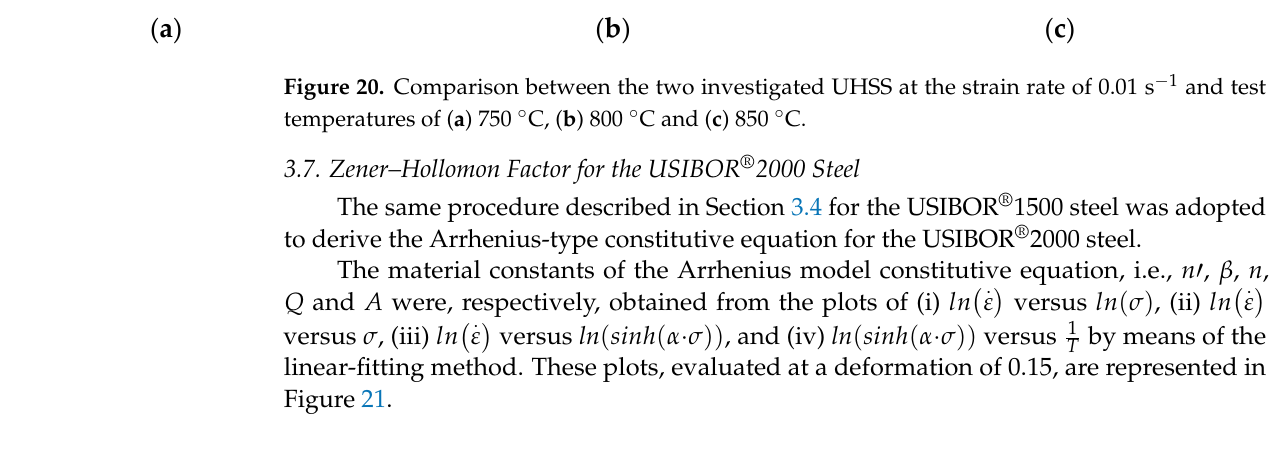
( d ) Figure 21. Relationship between ( a ) 𝑙𝑛𝜀̇ and 𝑙𝑛𝜎 𝑚𝑎𝑥 at different temperatures, ( b ) 𝑙𝑛𝜀̇ and 𝜎 𝑚𝑎𝑥 at different temperatures, ( c ) 𝑙𝑛𝜀̇ and 𝑙𝑛 (𝑠𝑒𝑛ℎ(𝛼𝜎 𝑚𝑎𝑥 ) at different temperatures, and ( d ) 𝑙𝑛 (𝑠𝑒𝑛ℎ(𝛼𝜎 𝑚𝑎𝑥 ) and 1 𝑇 at different strain rates. The coefficients 𝑛’ and 𝛽 can be obtained from the slopes of 𝑙𝑛(𝜀̇)– 𝑙𝑛(𝜎 𝑚𝑎𝑥 ) and 𝑙𝑛(𝜀̇)– 𝜎 𝑚𝑎𝑥 , respectively. The average values and the standard deviation of the coeffi- cients 𝑛’ and β are, respectively, equal to 13.374 ± 3.818 and 0.0663 ± 0.009. Considering that 𝛼 = 𝛽 𝑛′ , 𝛼 is equal to 0.00495.